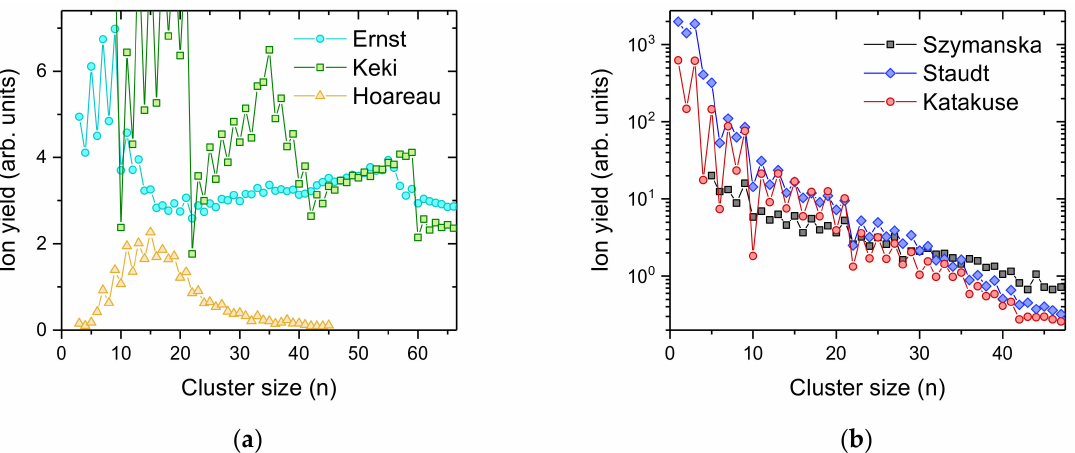
Figure 2. Cluster size distributions of positively charged silver clusters Ag n+ taken from the literature and made by different methods. In every case, the mass spectra exhibit pronounced intensity anomalies that can be assigned to spin pairing of the 5 s electrons and electronic shell closures most noticeably at n = 9, 21, 41 and 59. ( a ) shows silver cluster size distributions obtained by Ernst and Hauser (cyan circles, electron ionization of neutral Ag doped helium droplets [49]), Keki et al. (green squares, MALDI [47]) and Hoareau et al. (yellow triangles, inert gas condensation [41]); The cluster size distributions in ( b ) show an almost exponentially decreasing intensity with increasing cluster size from Szymanska et al. (black squares, laser desorption/ionization of silver benzoate [48]), Staudt et al. (blue diamonds, 15 keV Xe + ion sputtering [46]) and Katakuse et al. (red circles, 10 keV Xe + ion sputtering